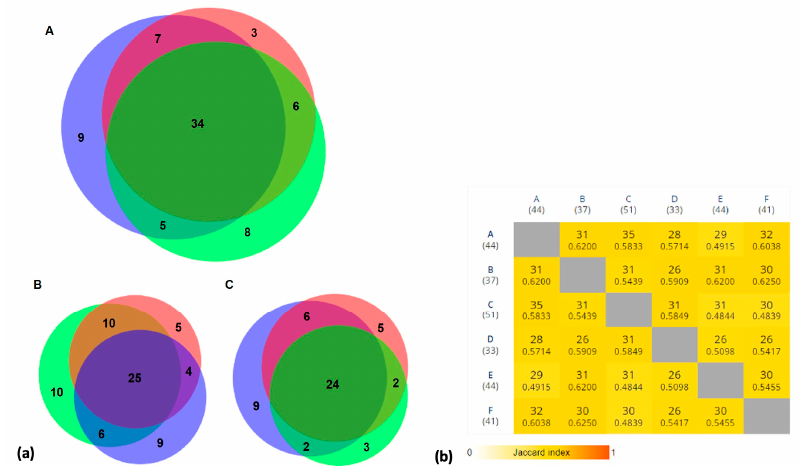
Figure 7. ( a ) Venn diagrams for the division of used taxa and use instances: A, recorded in Belarus (red), Lithuania (green), and Poland (violet); B, among Lithuanians living in Belarus (red), Lithuania (green), and Poland (violet); C, among Poles living in Belarus (red), Lithuania (green), and Poland (violet); ( b ) Jaccard similarity indices for the various compared groups based on detailed use reports, where A—Lithuanians in Belarus, B—Poles in Belarus, C—Lithuanians in Lithuania, D—Poles in Lithuania, E—Lithuanians in Poland, and F—Poles in Poland.